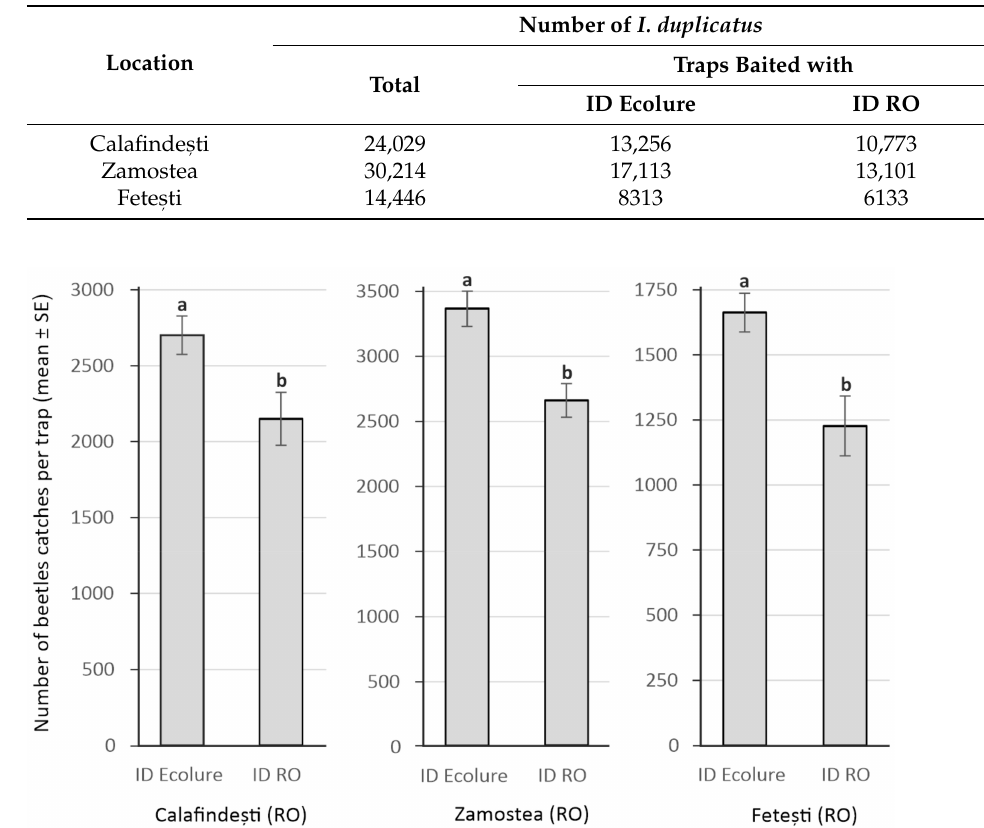
Table 2. Ips duplicatus beetles caught in the field in 2011 experiment.